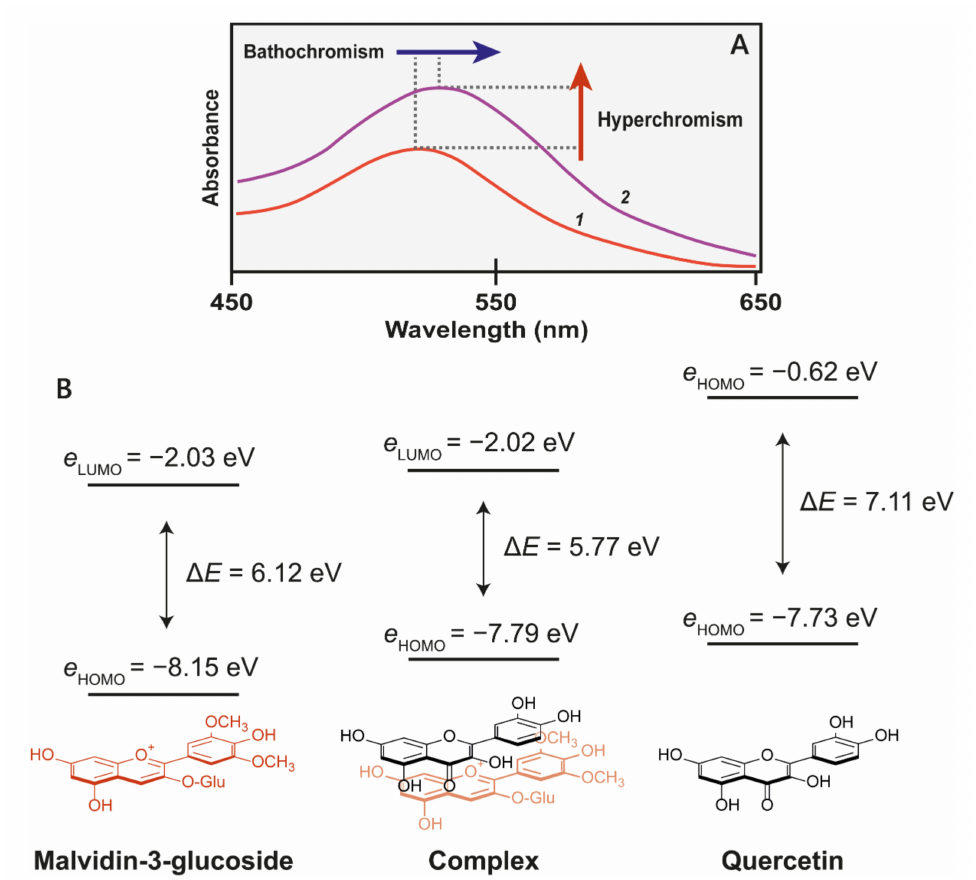
Figure 4. ( A ) Co-pigmentation of malvidin 3-glucoside with quercitin at pH 3.6. 1 = 500 µ M malvidin 3-glucoside, 2 = 500 µ M malvidin 3-glucoside + 1 mM quercitin [22]. ( B ) The molecular orbital correlation diagram of malvidin 3- O -glucoside and quercetin shows the energy changes as a result of co-pigmentation complex formation. Reduction of highest occupied molecular orbital of chromophores (HOMO)–lowest unoccupied molecular orbital (LUMO) energy gap ( ∆ E) results in a bathochromatic shift